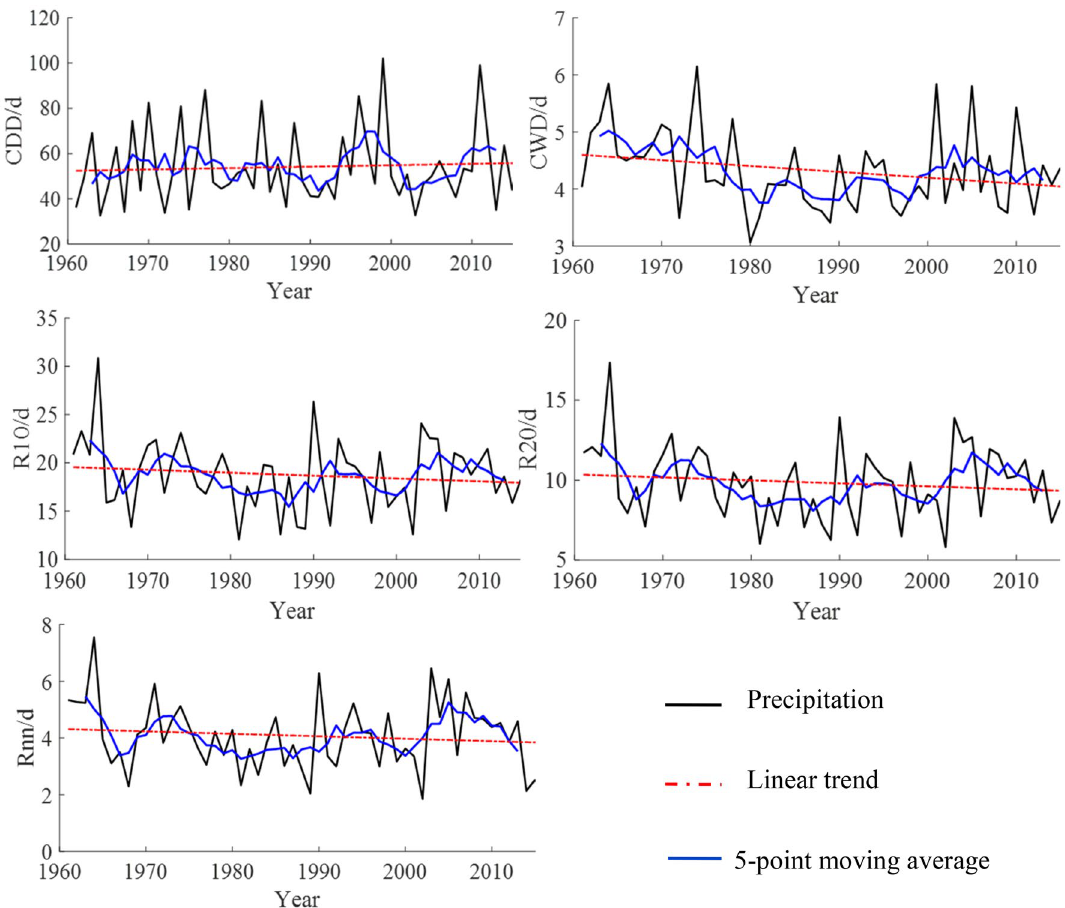
Figure 3. Temporal distribution of indices related to the amount of precipitation in Shandong from 1961 to